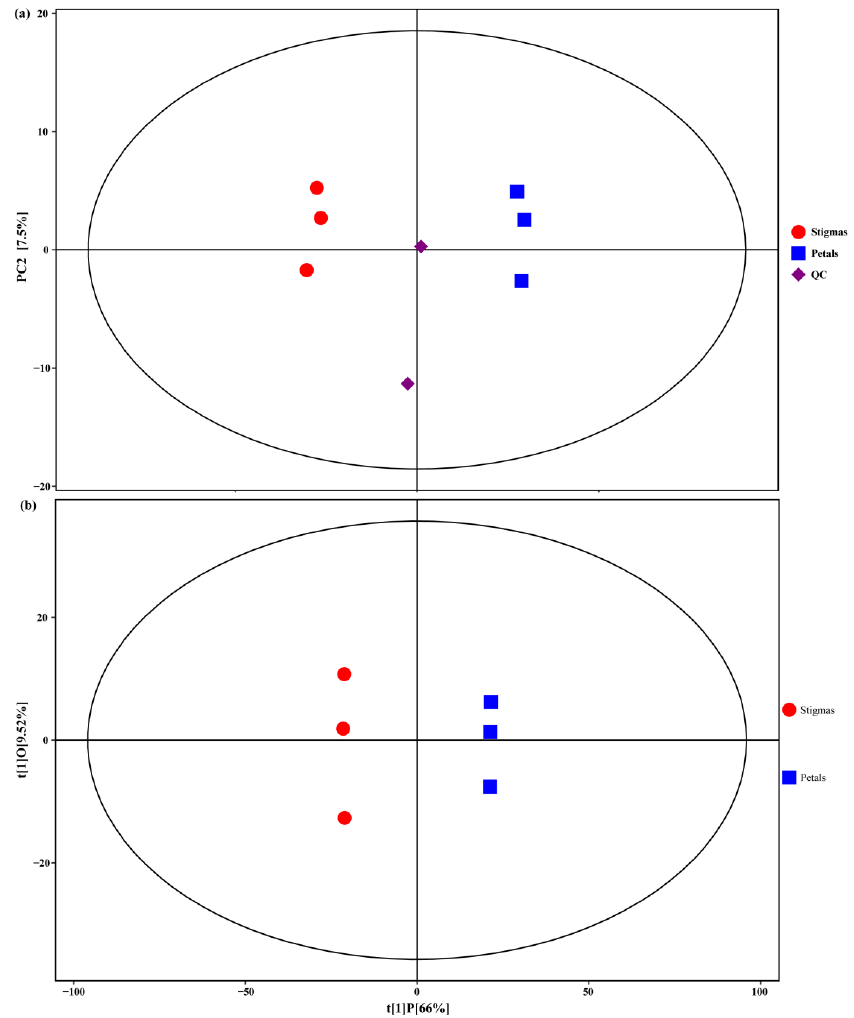
Figure 3. ( a ) PCA score plot of the metabolites in the stigmas and petals. ( b ) Score scatter plot of the OPLS-DA model for the stigmas vs. petals.